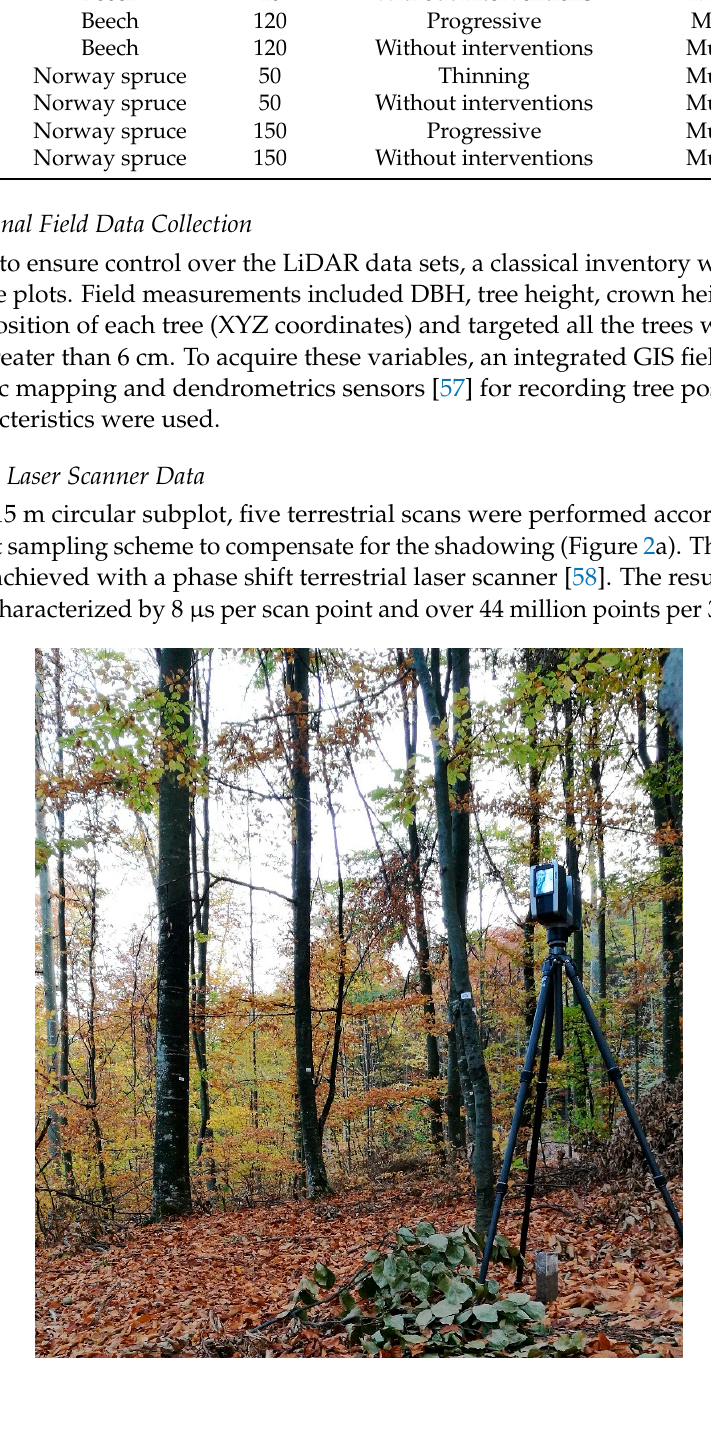
( b ) Figure 2. ( a ) TLS ground-based data collection ( b ) terrestrial laser scan of the subplots. 2.4. Airborne Laser Scanner Data The airborne LiDAR data for the one-hectare plots were collected through the use of a full-wave airborne laser scanner [60]. The discrete points extraction was conducted by